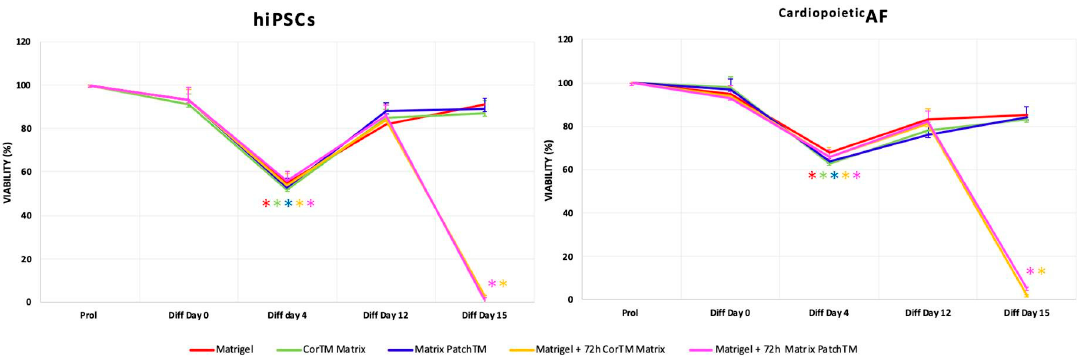
Figure 2. Percentage of hiPSCs and Cardiopoietic AF viability, obtained by 3(4,5-Dimethylthiazol-2yl)-2,5-Diphenyl Tetrazolium Bromide (MTT) assay performed under proliferation conditions once cells reached 60% confluency and under differentiation conditions at day 0, 4, 12, and 15 in all experimental conditions, as indicated. The graphs show the mean ± SD of five independent experiments; * p < 0.05.